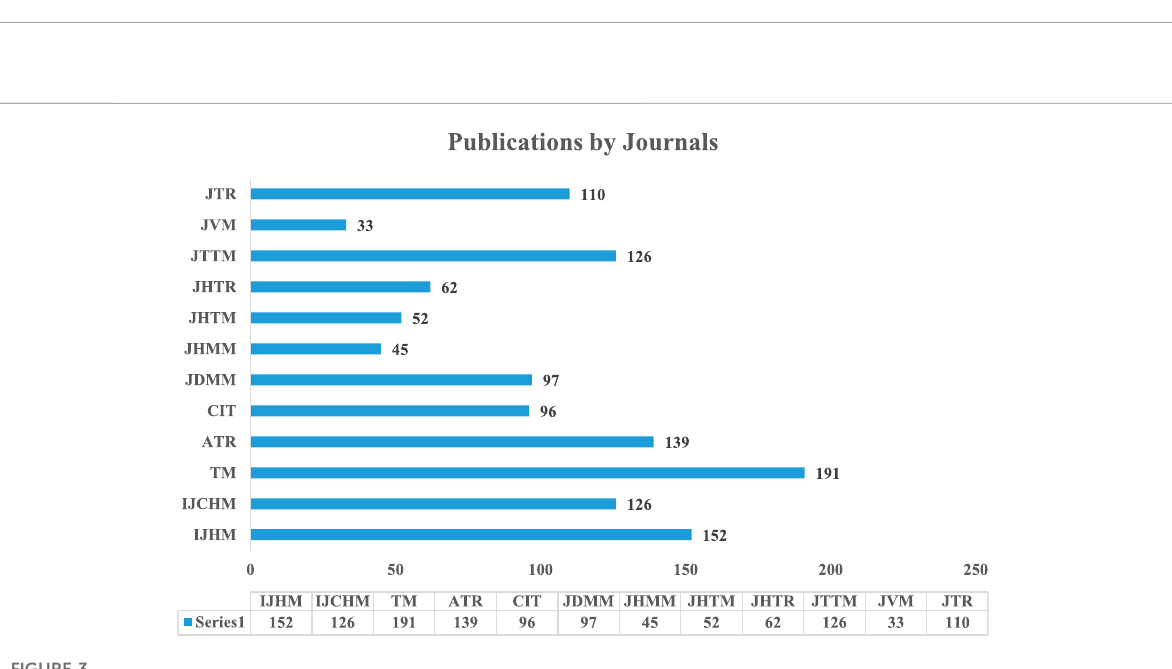
FIGURE 2 Evolution of publications in leading journals.